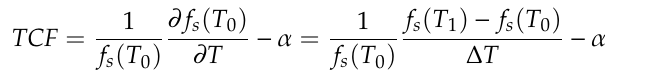
Figure 10. Simulated absorption spectra of the cross-shaped aperture absorber for four different incident angles.